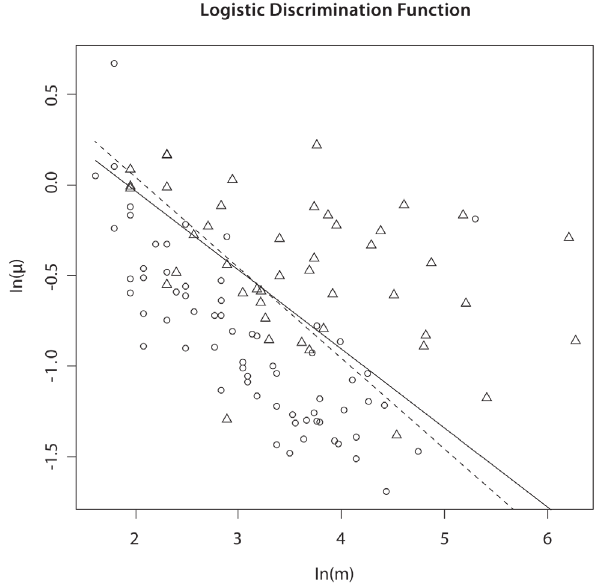
Figure 1. Logistic discrimination functions for Nimblegen X- chromosome data corresponding to optimal score ( a =0.44, solid line) and statistical information score ( a =0.5, dashed line). Triangles correspond to true positives, ellipses to false positives.